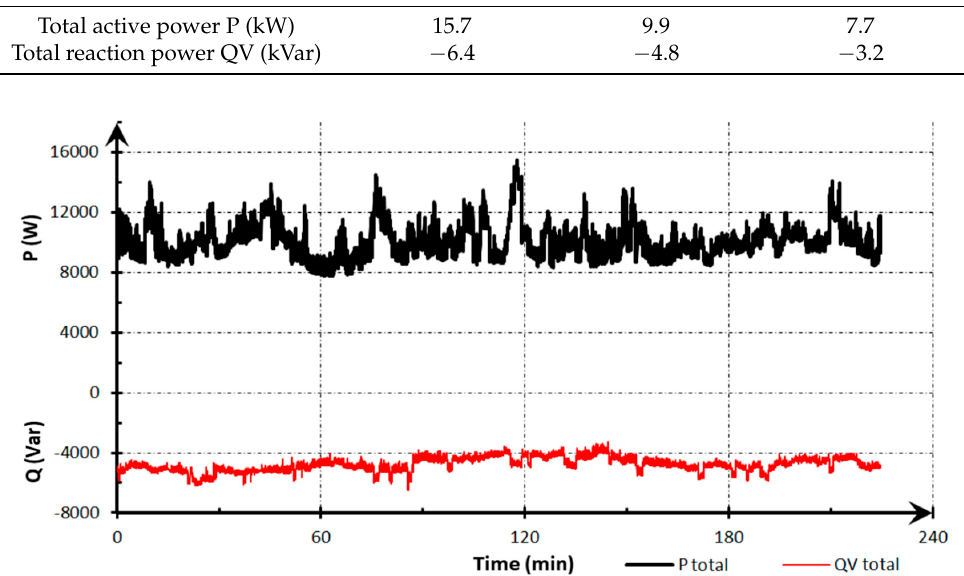
Figure 2. The course of total power variation in the monitored period.